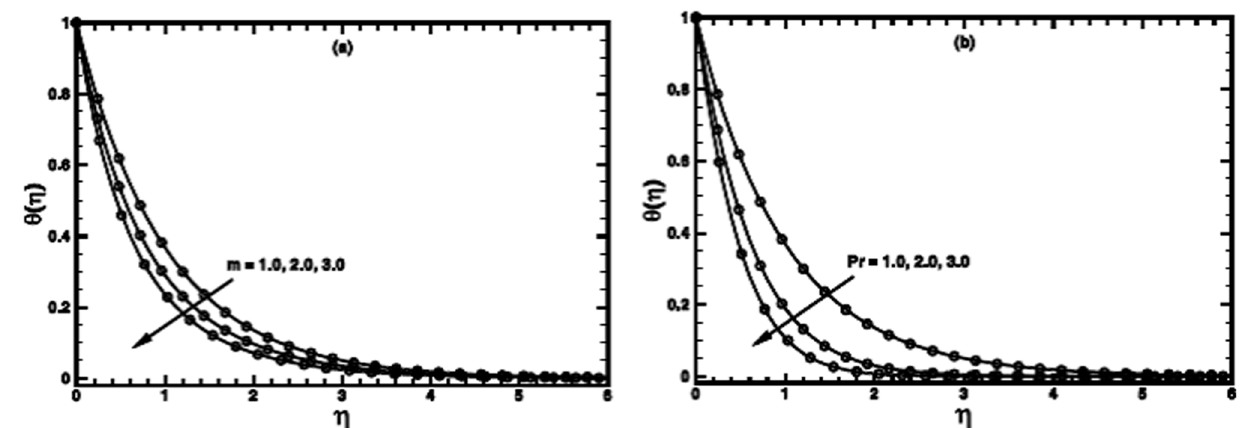
Figure 12. A comparison of the exact and numerical results (solid line numerical results and open circles exact results) in the PST when n ~ 1 , s ~ 1 and A ~ 0 are fixed.